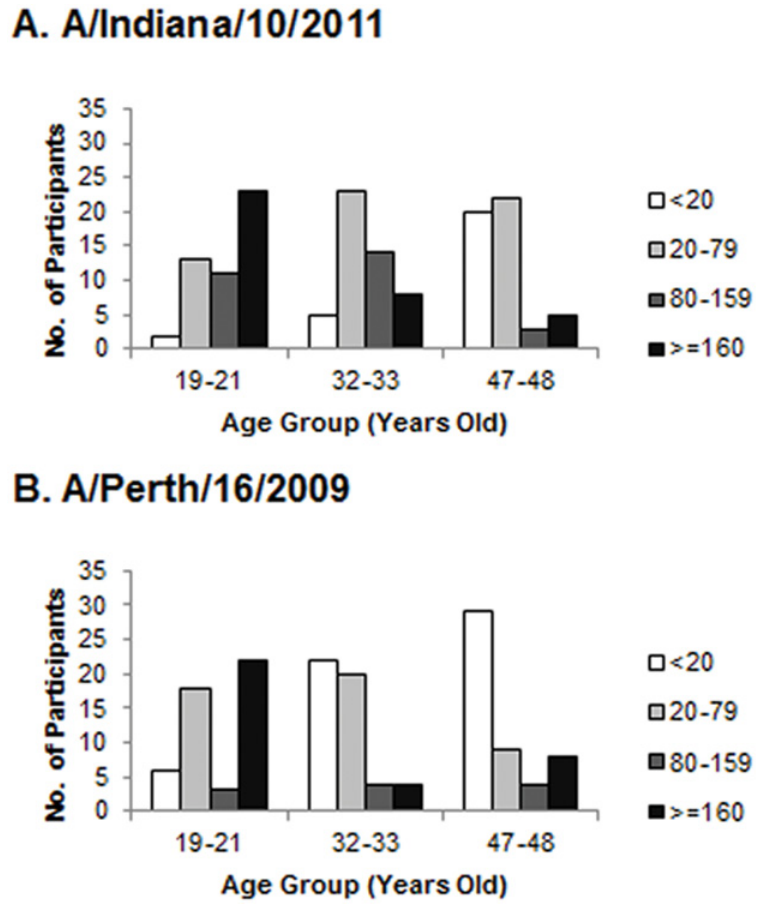
Fig 1. Postvaccination microneutralization titers by three age groups of US Department of Defense service members. (A) H3N2v (A/Indiana/10/2011) and (B) seasonal H3N2 (A/Perth/16/2009).